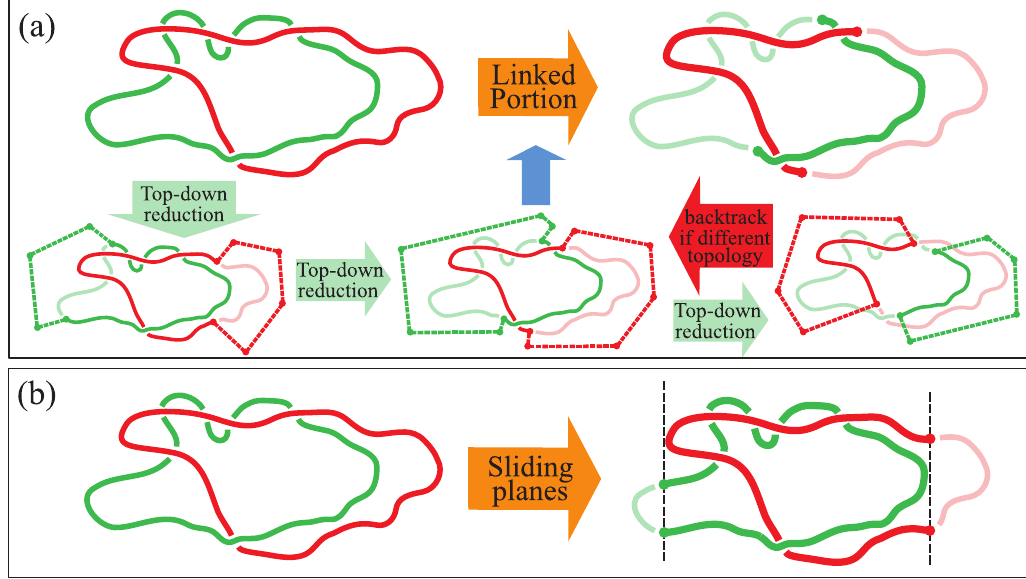
Figure 3. ( a ) Schematic illustration of the search strategy for locating the linked portion of two rings. The scheme is based on a top-down exploration of progressively shorter portions (arcs) of the two rings whose physically-linked state (established by closing each of them away from the center of mass of the partner arc) matches the initial linked state of the two rings. The search ends when the arcs cannot be further shortened without yielding a link type different from the original one. The viably-linked pair of arcs with the shortest total contour length, (cid:96) LK , is the sought linked portion. Adapted with permission from Ref. [22]. ( b ) Sketch of the “sliding planes" strategy for bracketing the linked portion. The dashed lines represent the projection of the planes (perpendicular to the pulling direction) that optimally bracket the linked portion. Each plane cannot be drawn closer to the other without intersecting both rings. The total contour length of the portion bracketed by the planes is indicated as (cid:96) S LK